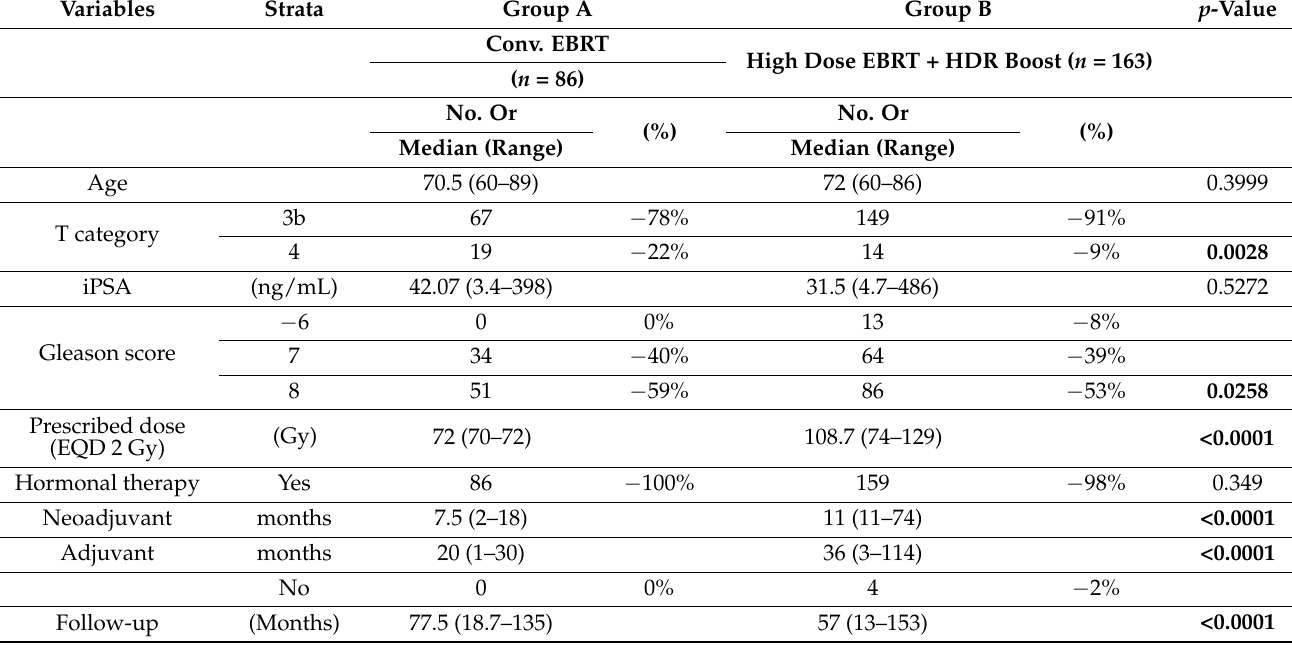
Table 1. Comparison of patients Characteristics between group A and group B.